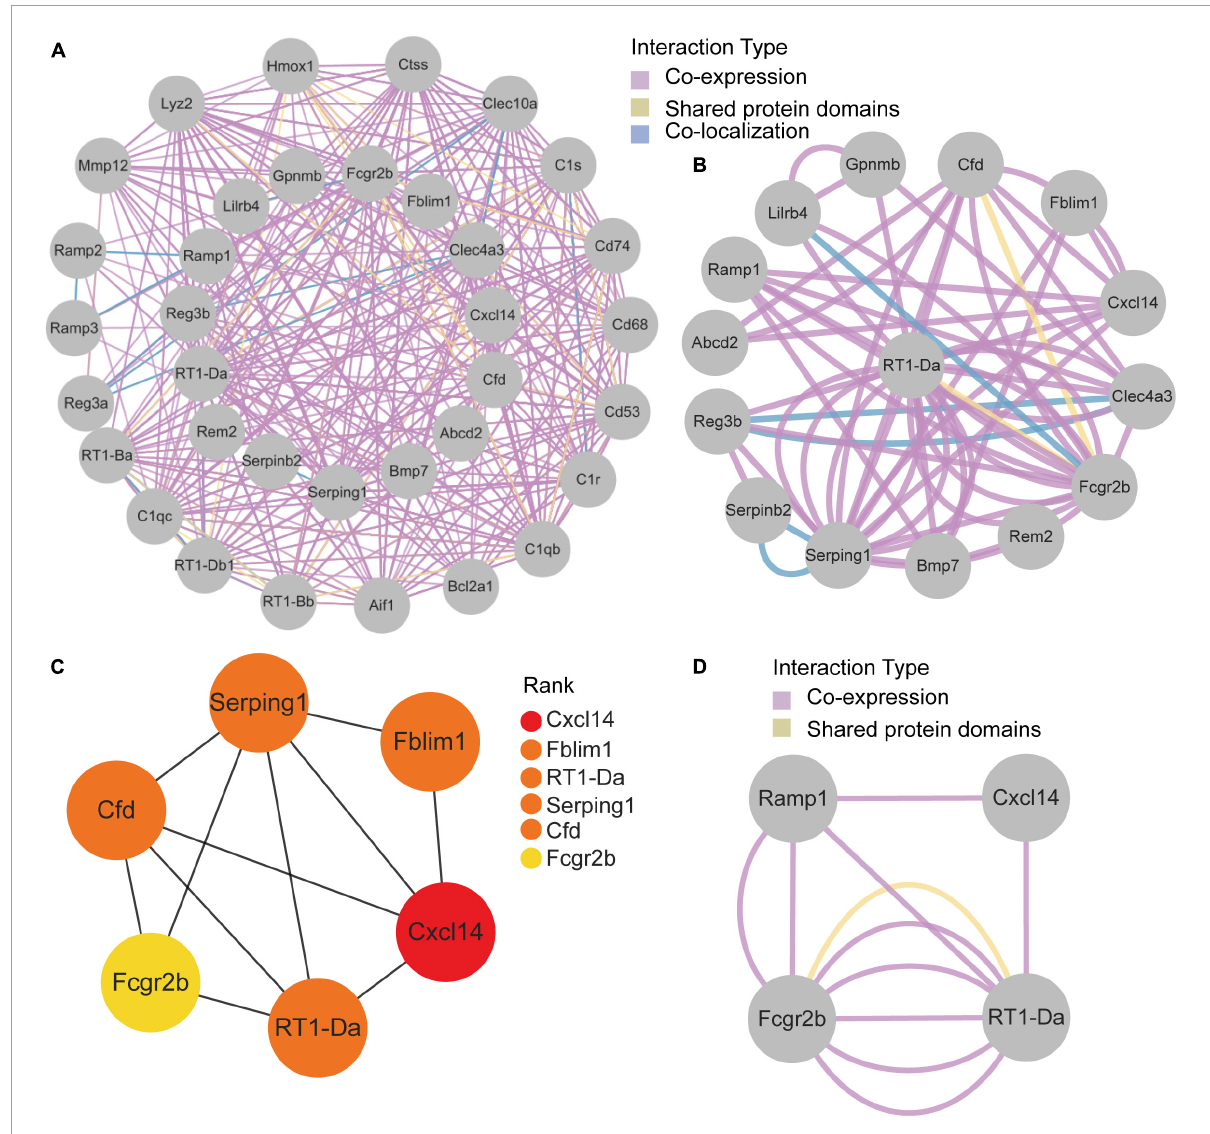
FIGURE5 Protein-Protein Interaction network of co-DEGs. (A) co-DEGs and their co-expression genes were analyzed using GeneMANIA database. The 20 most frequently changed neighboring genes are shown in the outer circle. co-DEGs are shown in the inner circle. Each node represents a gene. The line color represents the types of network interaction. (B) co-DEGs interaction network. The line color represents the types of network interaction. (C) Top 6 hub genes identified by cytoHubba plug-in. Nodes with different color represent different rank. (D) A significant cluster module extracted by MCODE. Each node represents a gene. The line color represents the types of network